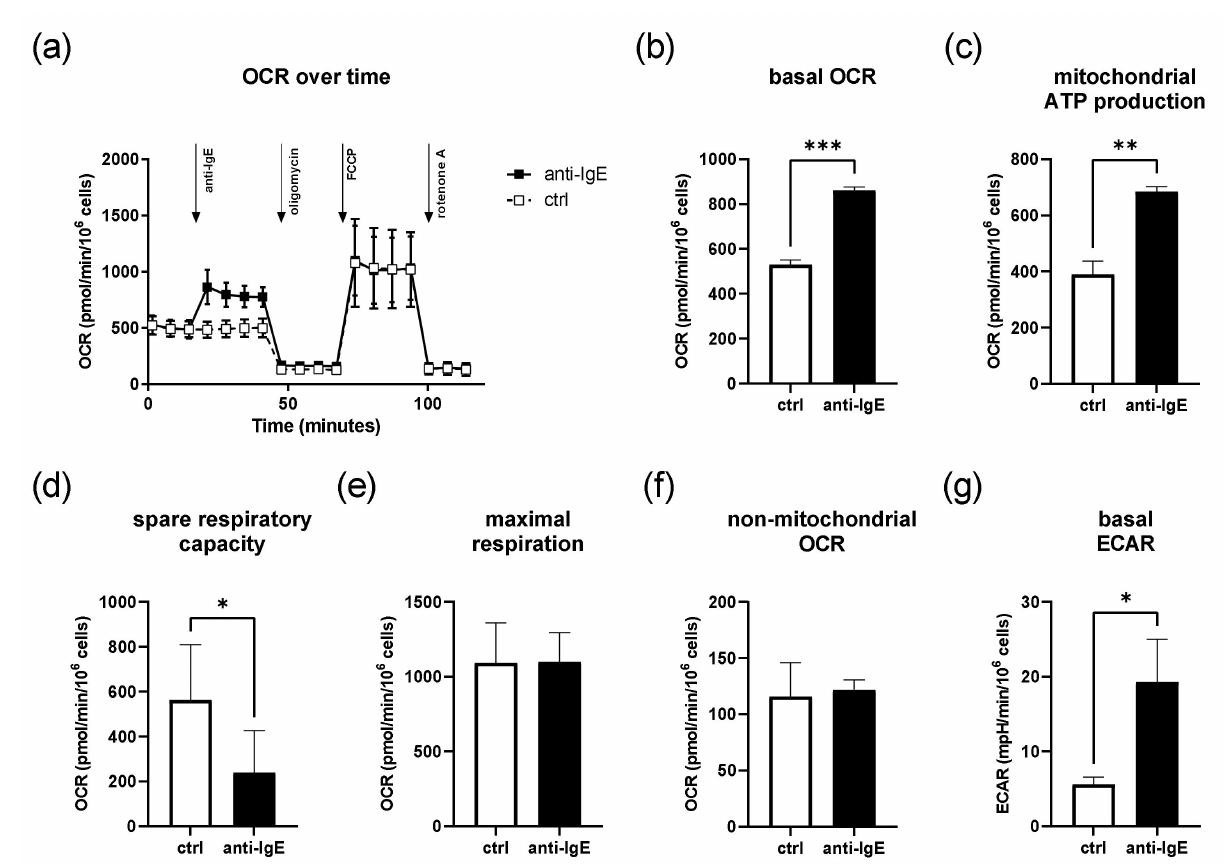
Figure 1. IgE-mediated activation of human skin MCs enhances mitochondrial respiration and extra-cellular acidification. ( a – f ) After IgE-mediated stimulation, the human skin MCs’ oxygen consumption rate (OCR) and mitochondrial parameters as well as extracellular acidification rate (ECAR) ( g ) were analyzed under glucose-free conditions in an Agilent Seahorse TM metabolic flux analyzer ( a , g ): n = 3, mean ± SEM, paired Student’s t -test: * p < 0.05, ** p < 0.01, *** p < 0.001). anti-IgE = IgE-preloaded cells cross-linked with anti-IgE; ctrl =